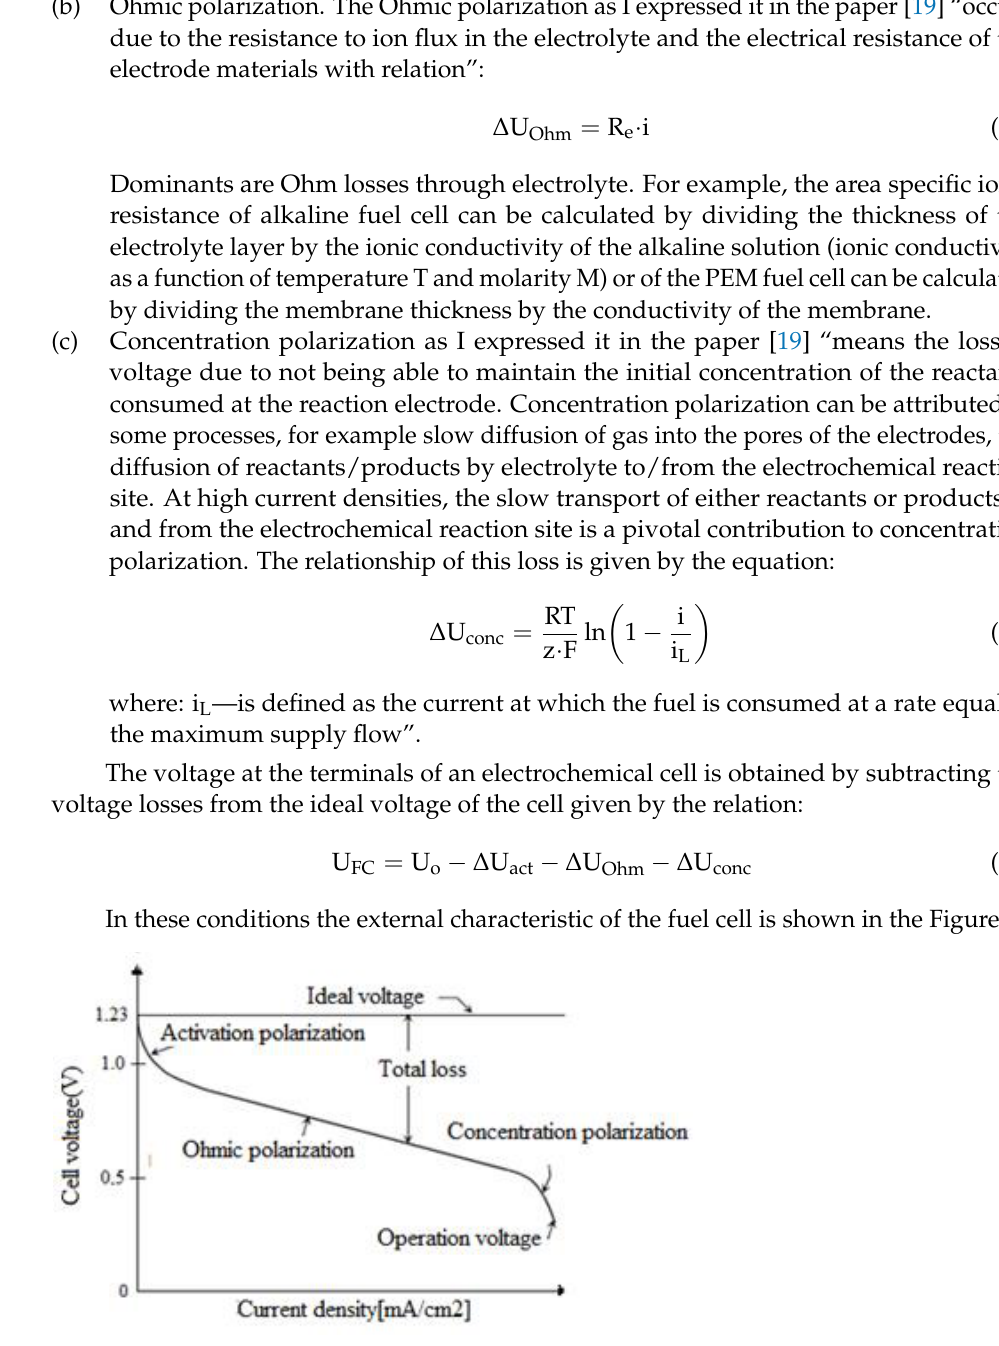
Figure 12. V-I characteristic of a single PEM fuel cell